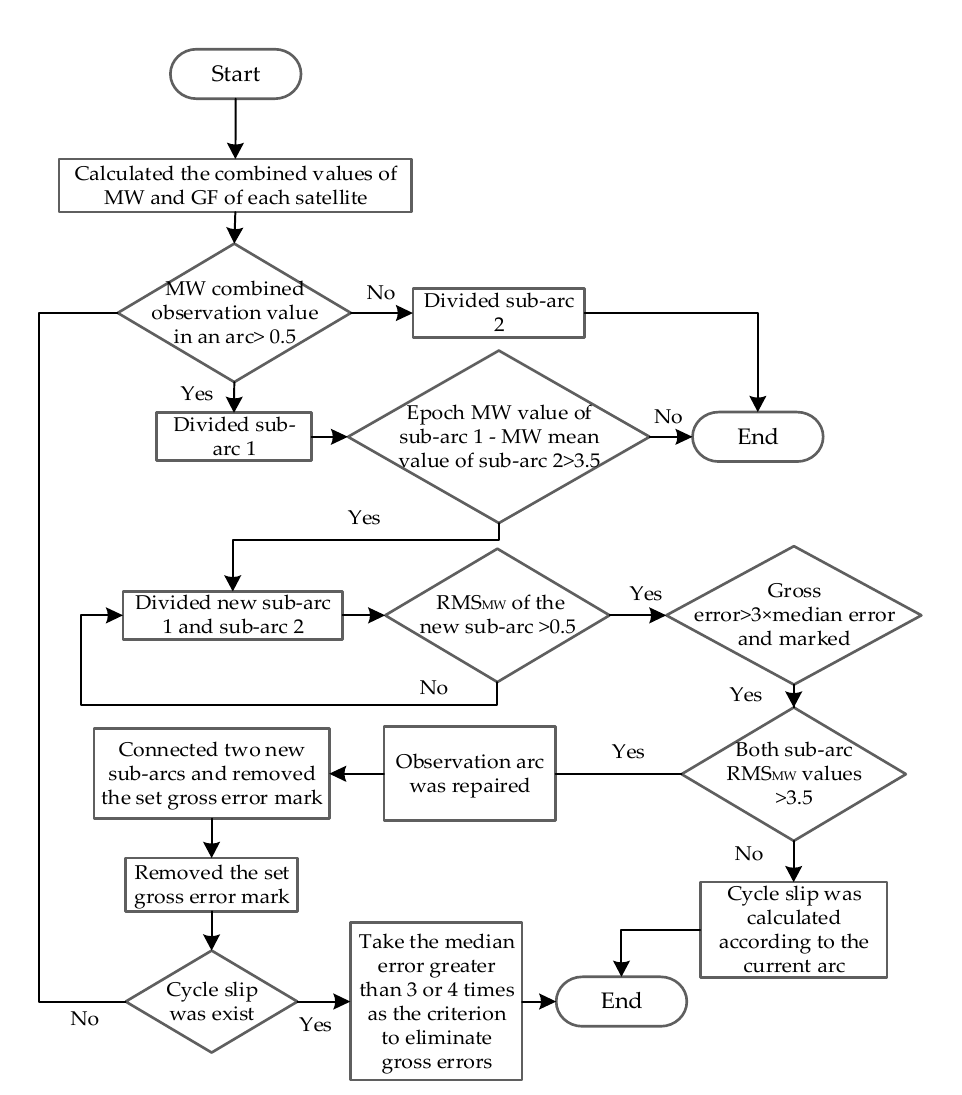
Figure 1. Flow chart of new arc partition method.